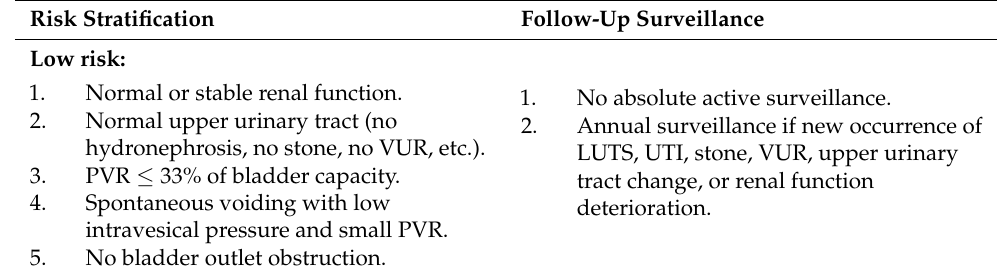
Table 3. Classification of risk and follow-up surveillance in patients with chronic spinal cord injury to avoid urological